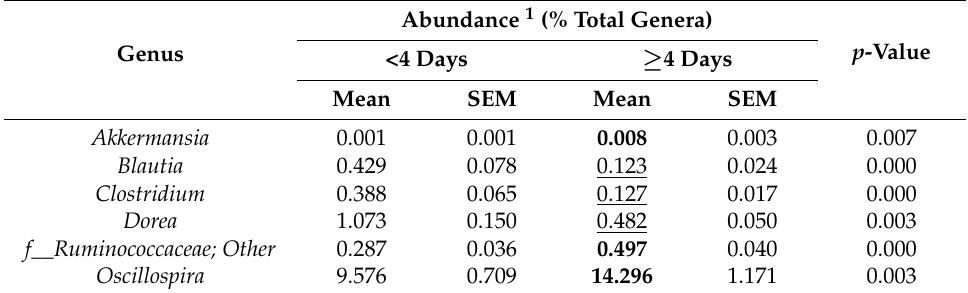
Table 3. Changes in the abundance of bacterial genera in cecal microbiome of rats ( n = 6) fed up to 14 days of cooked broccoli diet; Study 1.